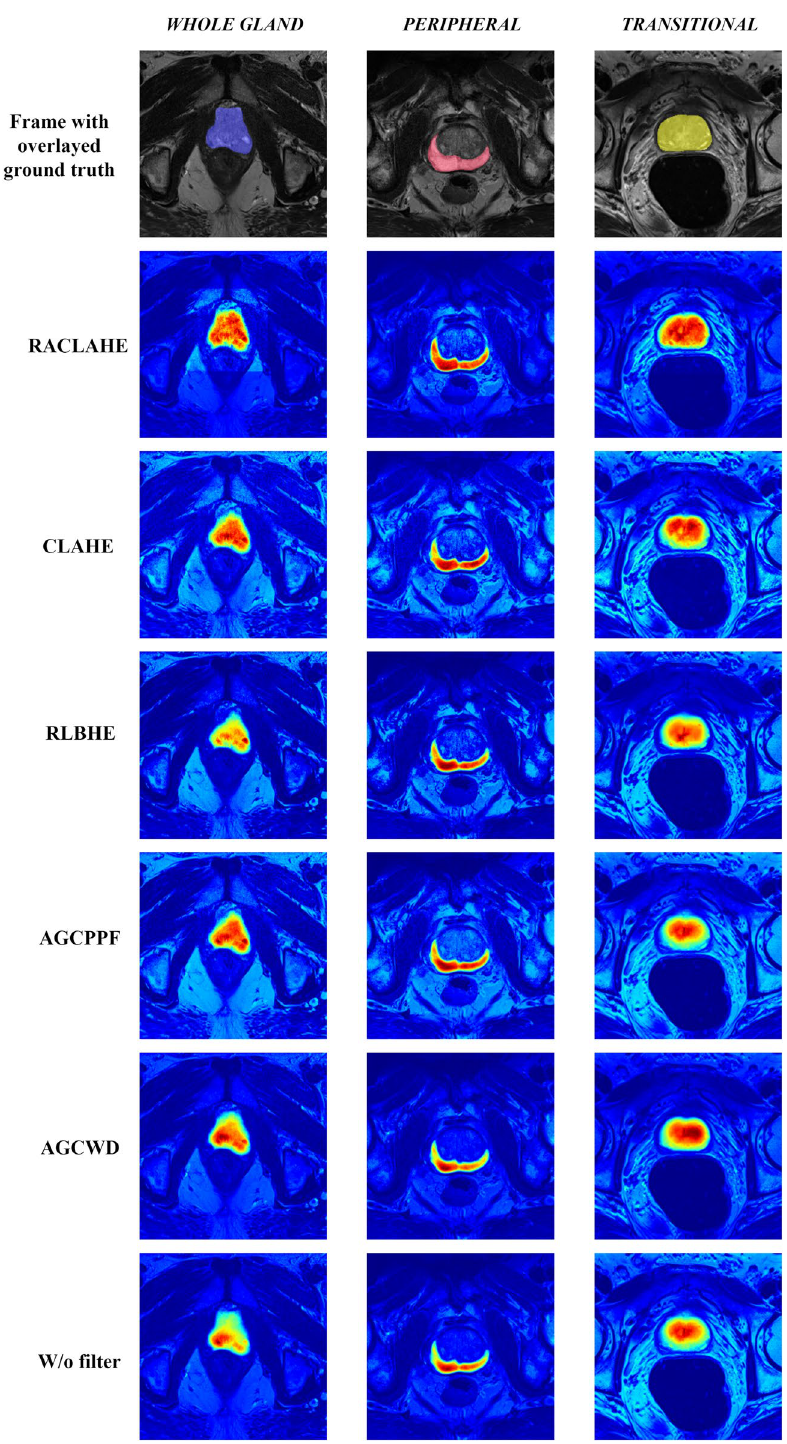
Figure 3. Weighted heatmap for the USE-Net model and for each preprocessing method used. The columns are the prostatic zones while the rows are the evaluated